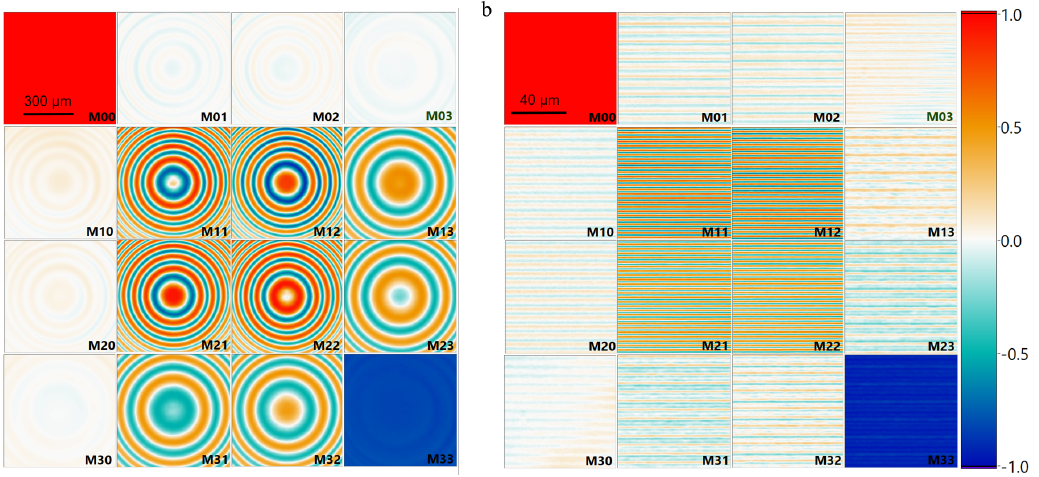
Figure 3. Normalized Mueller matrix images for the lens ( a ) and the grating ( b ). The scale bar is indicated in the M 00 element.